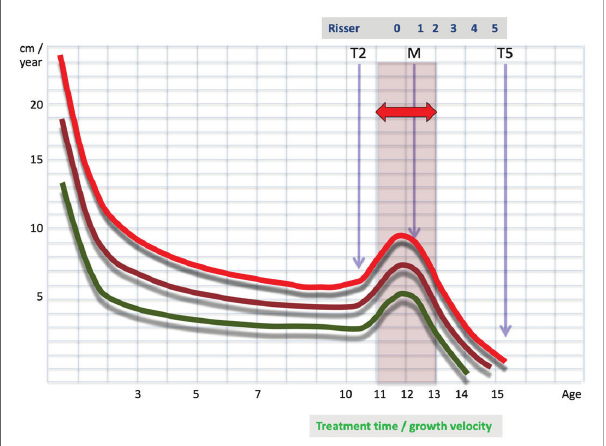
FIGURE 5: Follow-up during the treatment period for the 9.9-year-old premature patient with Tanner 2–3 at the start of treatment that is the normal maturity of an 11-year-old girl. T2 (Tanner 2) = the first signs of maturation; M = onset of menarche; Risser stage 1 appears after the onset of menarche and between 15 and 16 years a normal girl has fully matured (Risser 5 or Tanner 5). The three coloured lines describe the normal variation of the normal growth velocity (modified according to Weiss et al.